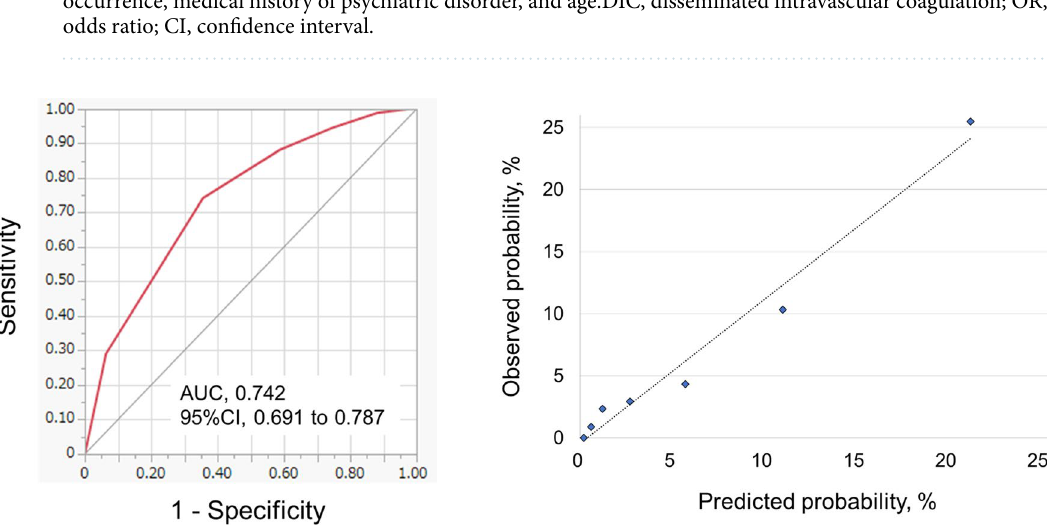
Figure 2. The area under the receiver operating characteristic curve of the J-ERATO score to predict mortality after heat-related illness. ( A , left) The J-ERATO score cut-off of 5 points provided optimal sensitivity and specificity to predict mortality at discharge (AUC [95%CI], 0.742 [0.691–0.787]; sensitivity, 74.2% [64.5–82.0]; specificity, 64.4% [61.7–67.0]; PPV, 13.5% [10.8–16.7]; NPV, 97.1% [95.7–98.0]; positive likelihood ratio,